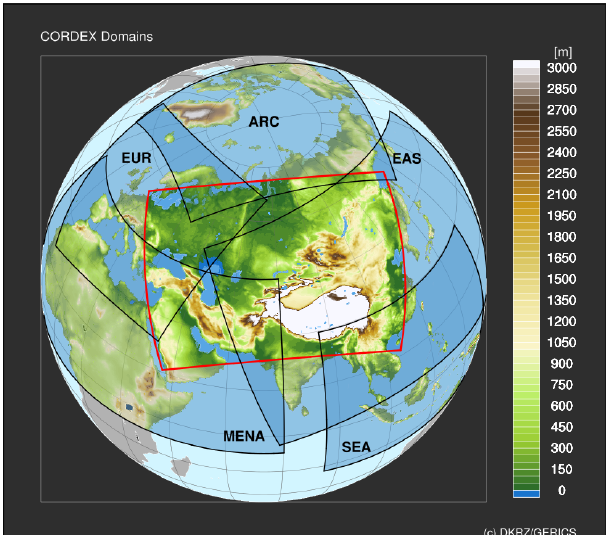
Figure 2. IPCC6 subregions projected on the CAS-CORDEX re-